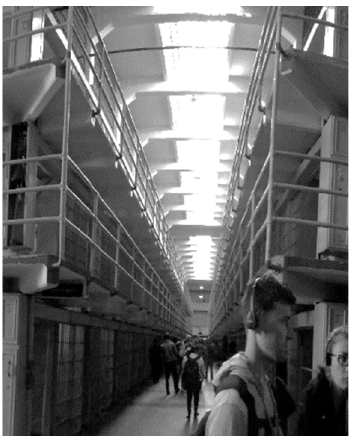
Figure 19. A view of the double loaded corridor at Alcatraz.